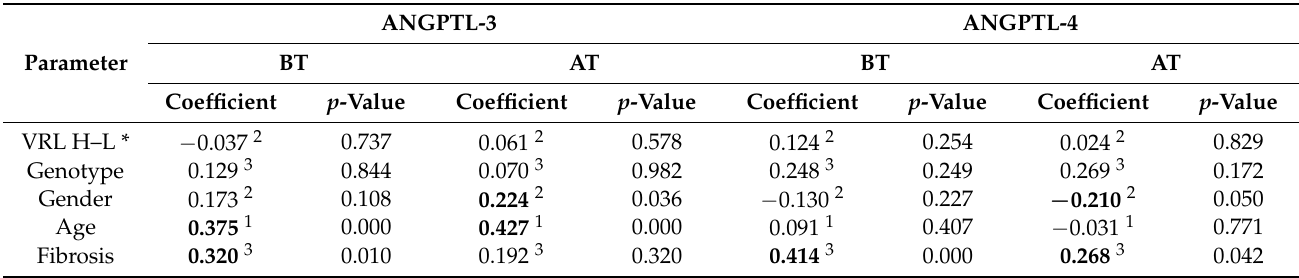
Table 5. Univariate association analysis of clinical and infection parameters with ANGPTL-3 and ANGPTL-4 sera levels in matched samples of chronic HCC patients before (BT) and after (AT) treatment with DAAs.